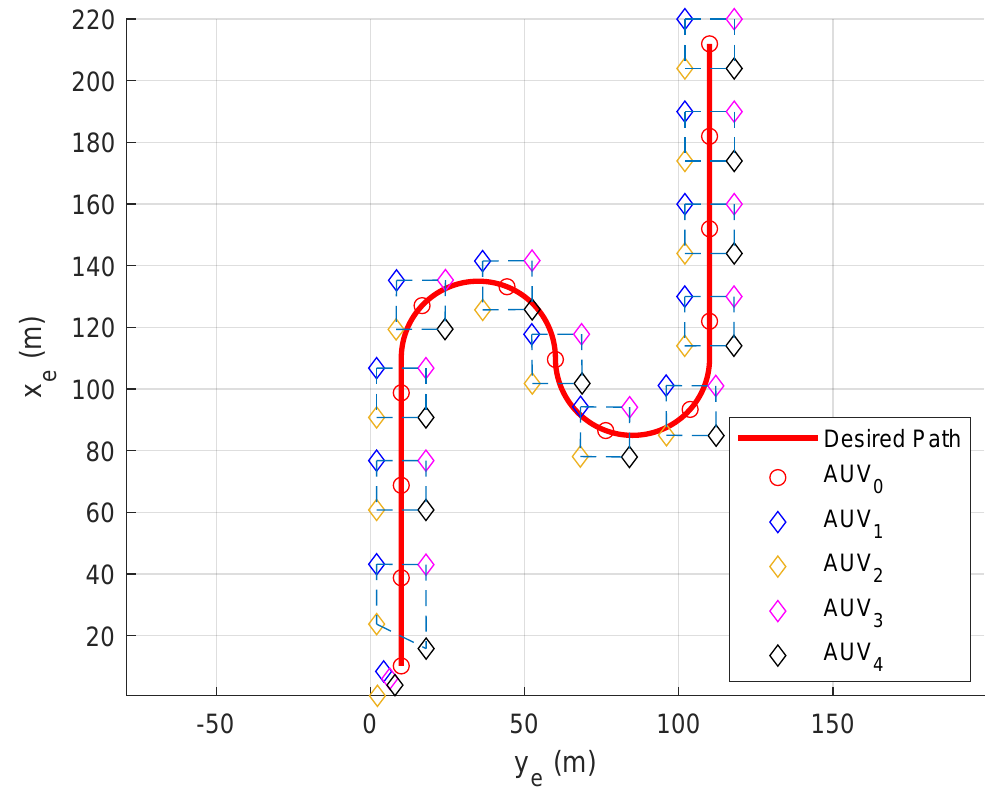
Figure 13. Trajectory of multi-AUV under alterable communication topology without